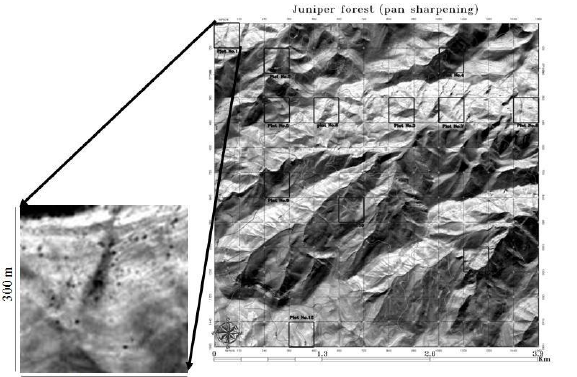
Figure 4. Arrangement of the 9-ha juniper sampling plots. The 12 highlighted plots are those randomly chosen for analysis Image